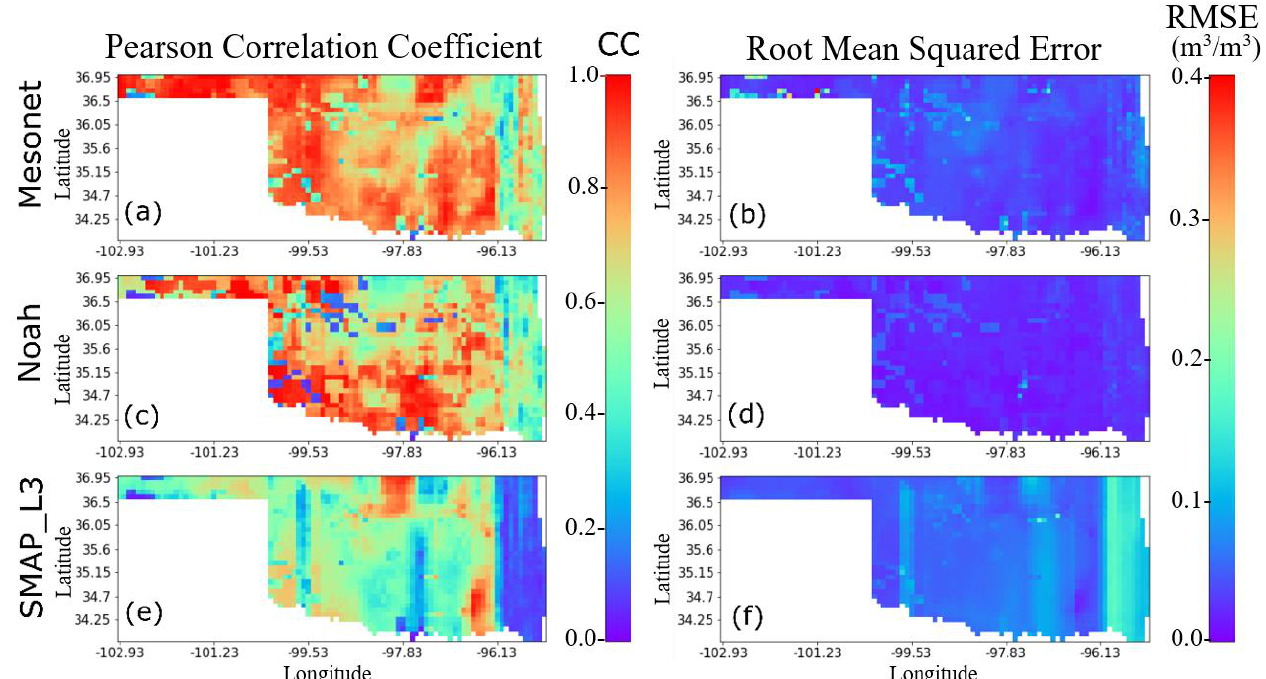
Figure 5. Product intercomparison assessment through CC (left column) and RMSE (right column) after applying the TC method for Mesonet (first row), Noah (second row), and SMAP (third row) surface soil moisture products based on morning 6 a.m. values from April 2015 to July 2019, integrated (averaged) only during the spring season months (i.e., March, April, and May). Table 5. Climate-division averaged CC and RMSE from the TC triplets at local 6:00 a.m. from April 2015 to July 2019, for Mesonet, Noah, and SMAP during the spring season months (i.e., March, April, and May) for nine climate divisions in Oklahoma.